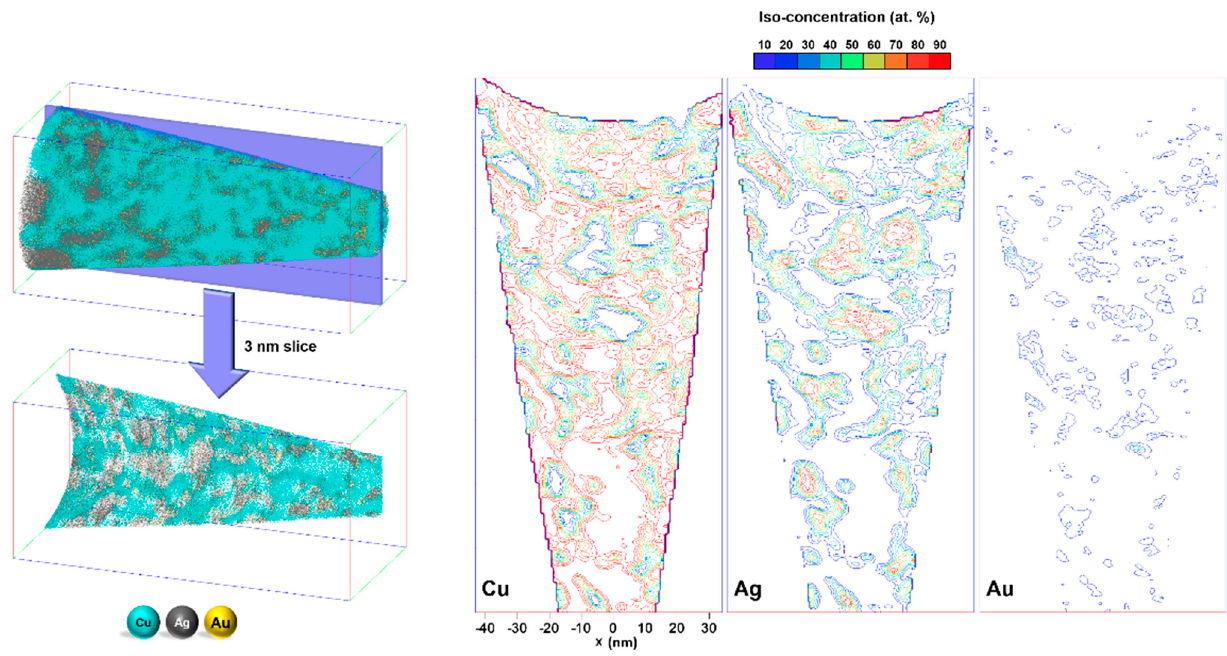
Figure 1. A 3 nm slice of the Cu-filled NPG developed from Ag 94 Au 5 Pt 1 alloy (for detailed dealloying and APT procedures please refer to [9]) with different iso-concentration contour lines, color-coded for different at. % Cu, Ag, and Au values of 10 to 90%.